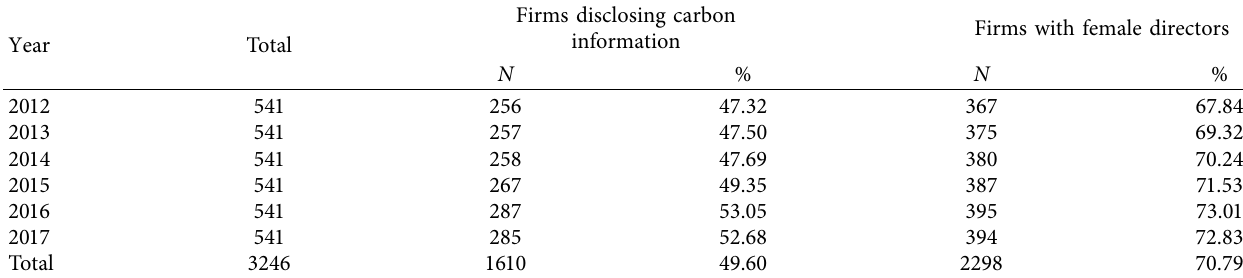
Table 5: The percentage of firms disclosing carbon information and having female directors.